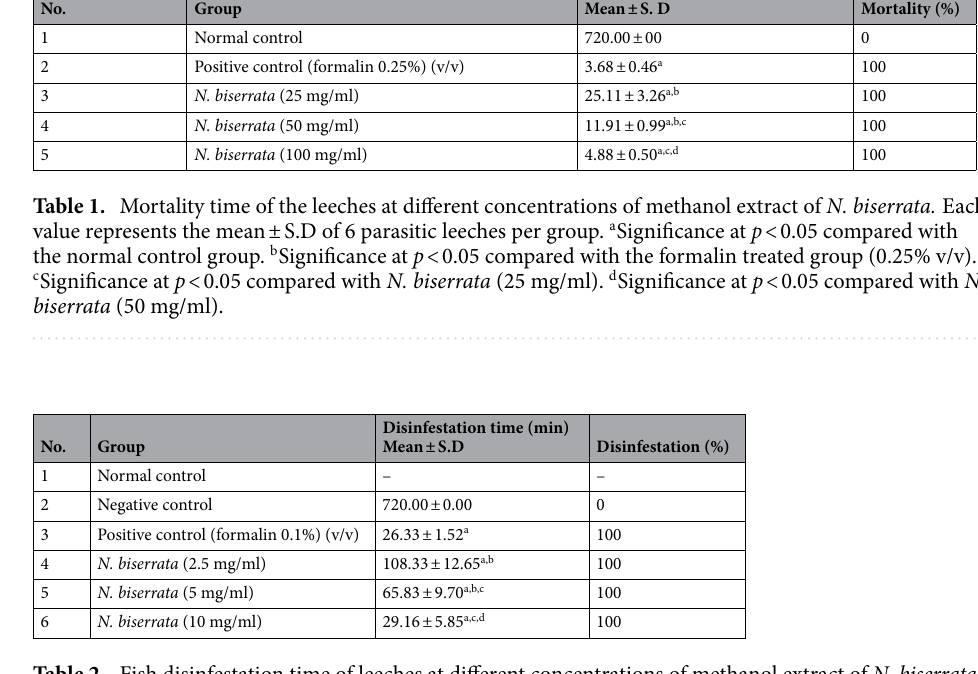
Table 2. Fish disinfestation time of leeches at different concentrations of methanol extract of N. biserrata. Each value represents mean ± S.D of 6 fishes per group. a Significance at p < 0.05 compared with the negative control group. b Significance at p < 0.05 compared with the formalin treated group (0.1%) (v/v). c Significance at p < 0.05 compared with N. biserrata (2.5 mg/ml). d Significance at p < 0.05 compared with N. biserrata (5.0 mg/